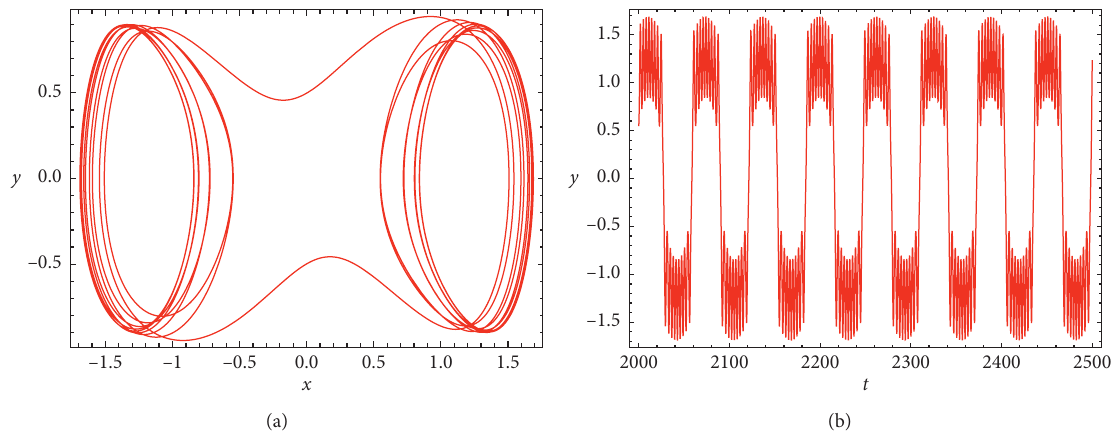
Figure 4: The phase trajectory (a) and time series (b) for the parameters a � b � α � 1 , ω